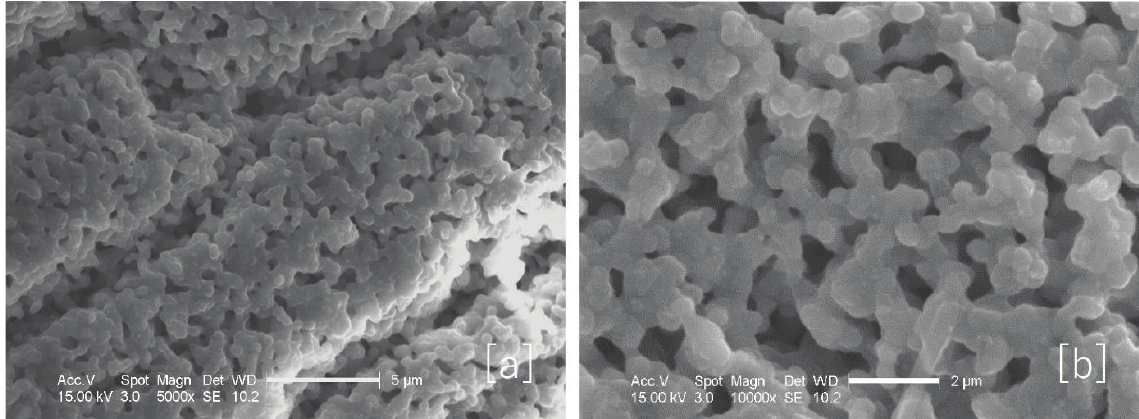
Fig. 7 – Surface of the SO grain after thermal activation at 523 K, BSE, magnification: a) 5000x, b) 10000x